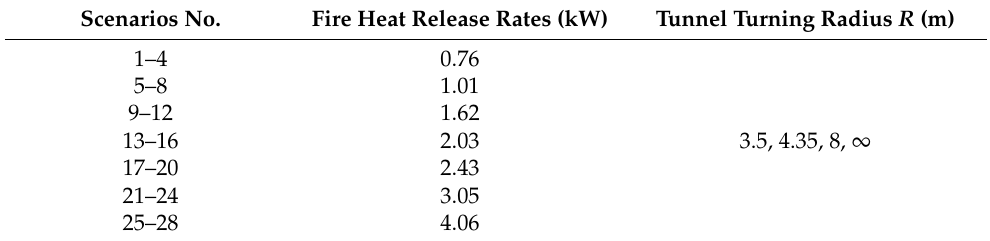
Table 1. The experimental scenarios conducted in the small-scale curved tunnel. Scenarios No.